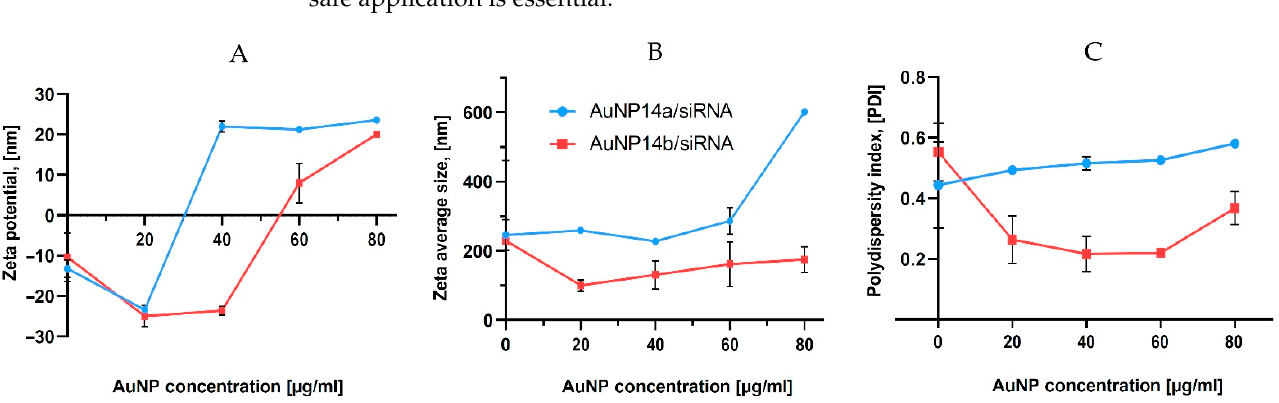
Figure 1. Zeta potential ( A ), hydrodynamic diameter ( B ) and polydispersity index ( C ) of siRNA alone and in the presence of increasing amounts of studied gold nanoparticles. Measurements were performed by the titration method. siRN concentration, 1 µM. The results represent mean values with standard deviation ( n = 3).